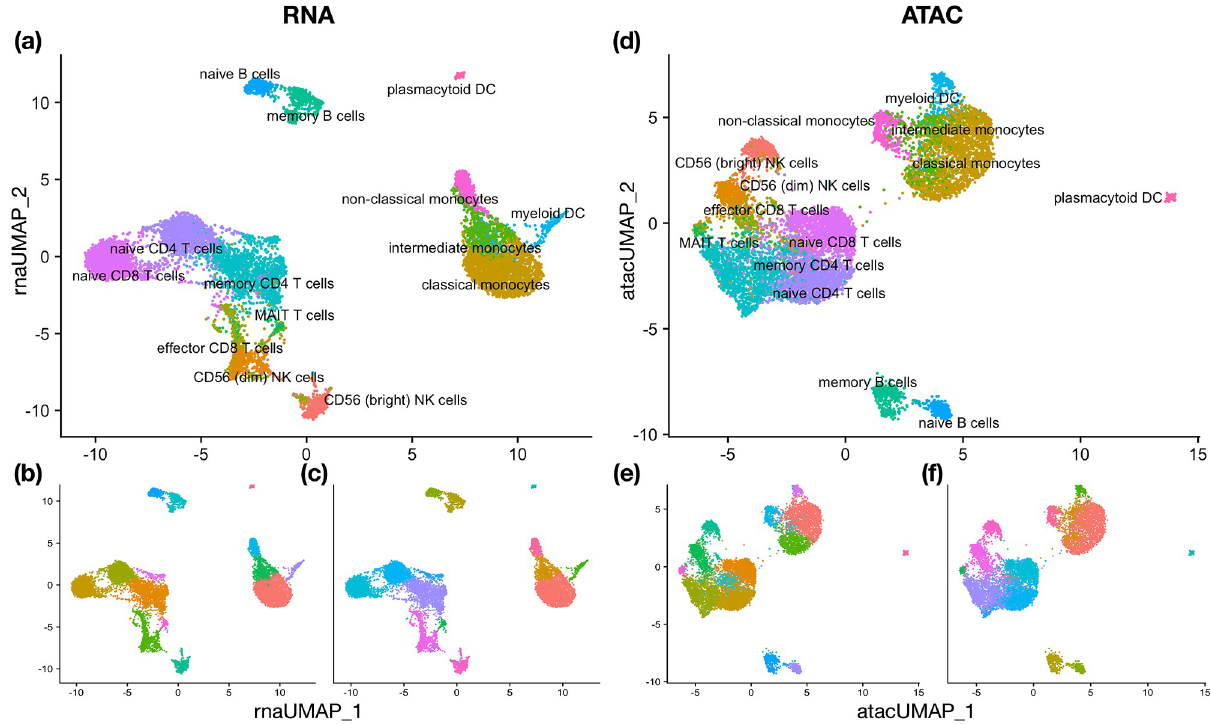
Fig 4. UMAP visualization for PBMC1 data and the clustering results. (a) Truth clusters on RNA. (b) Single-view clustering result on RNA. (c) CPS- merge analysis result on RNA. (d) Truth clusters on ATAC. (e) Single-view clustering result on ATAC. (f) CPS-merge analysis result on ATAC.